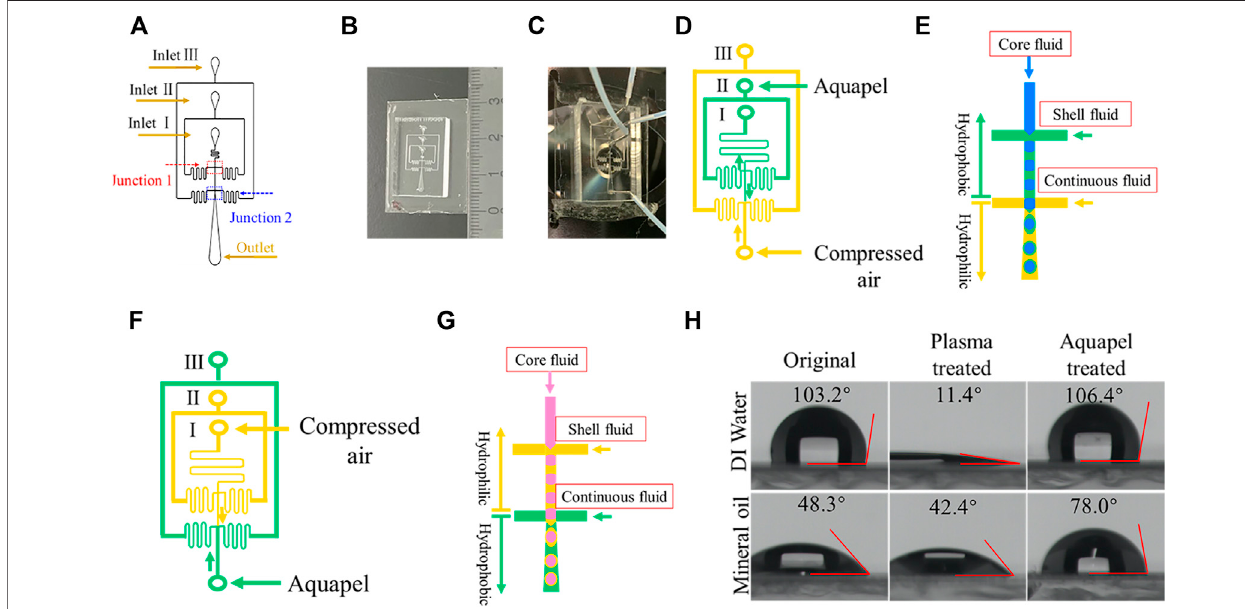
FIGURE 1 | Chip design and micro fl uidic channel surface modi fi cation. (A) Schematic diagram showing the layout of the micro fl uidic device. The looping channels serve to increase fl ow resistance. (B) Photograph showing the size of a PDMS device. (C) Photograph of a PDMS device connected with tubing. (D) Hydrophobic modi fi cationwithAquapelofdesignatedchannels(green)forformingw/o/wDEdroplets.Thearrowsindicatethedirectionofliquid fl ow. (E) Schematicillustrationofw/o/ w DE droplets generation process. (F) Hydrophobic modi fi cation with Aquapel of designated channels for forming o/w/o DE droplets. (G) Schematic illustration of o/w/oDEgenerationprocess. (H) Contactangle( θ )ofwaterandmineraloildropletsonanuntreatedPDMSsurface,afterplasmatreatment,andafterAquapeltreatment,